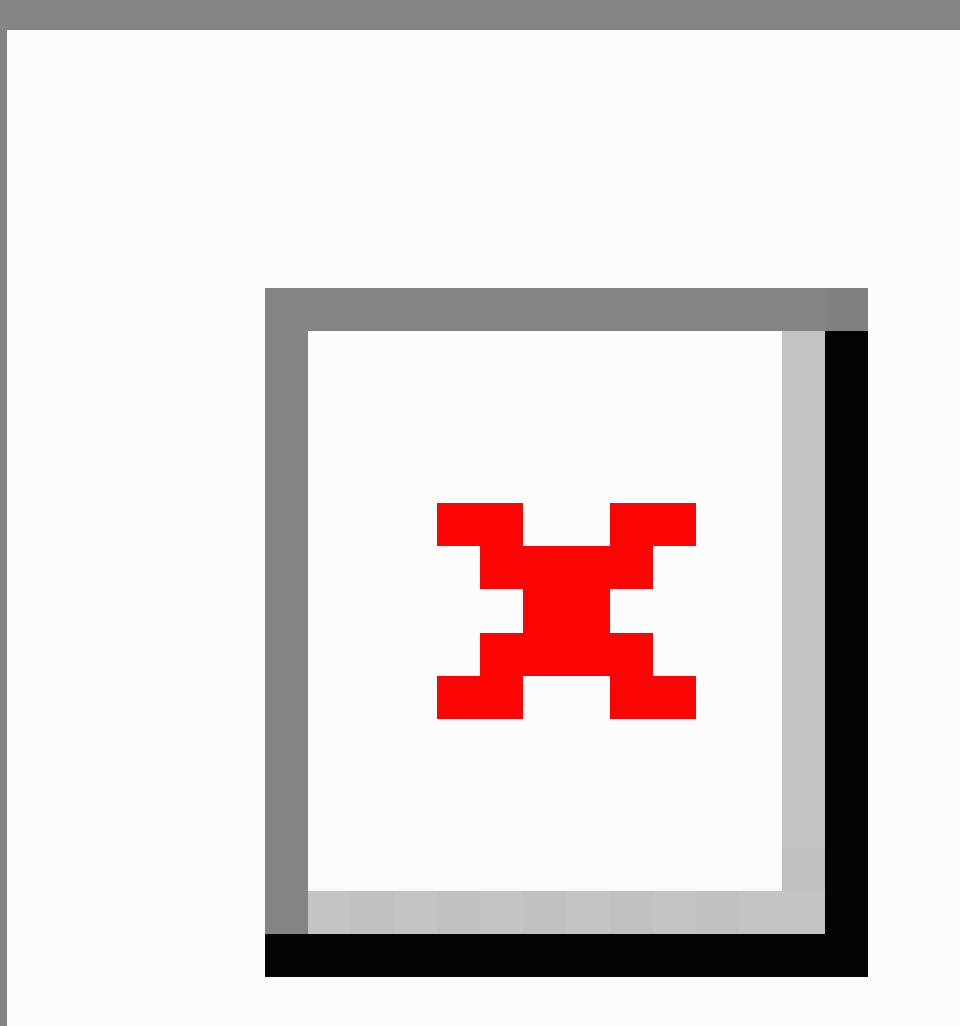
Figure 1. Mayo Clinic conference center virtual world platform in the Second Life